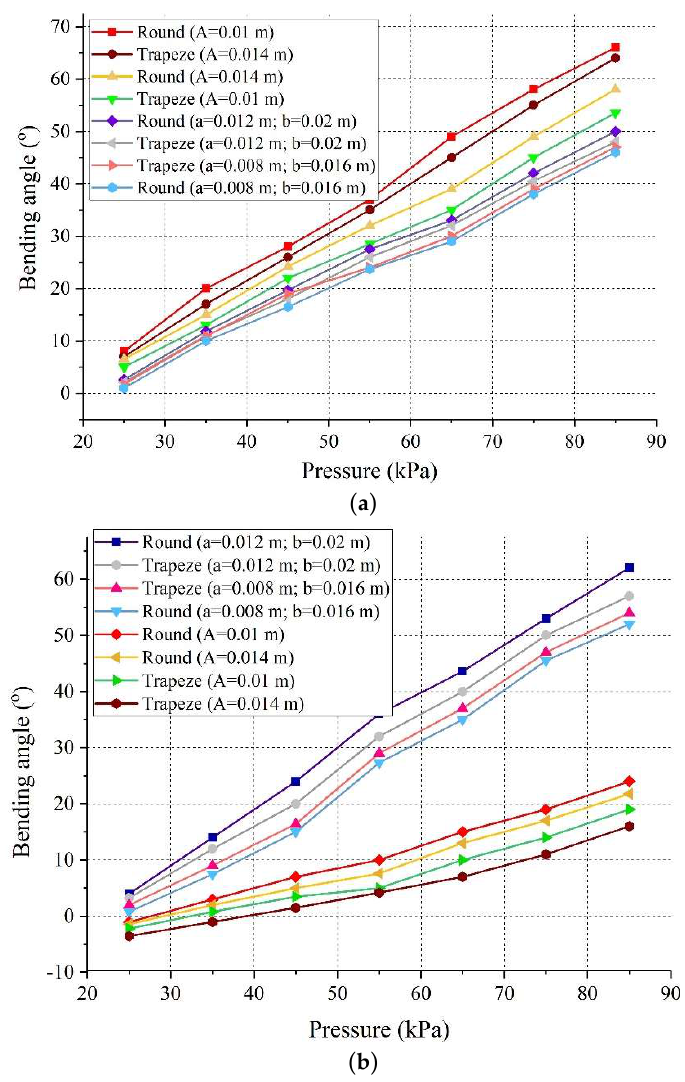
Figure 4. Comparison of finite element method (FEM) models: ( a ) Plot showing a comparison of the bending along the X -axis for each model, when the middle chamber was inflated. ( b ) Plot showing a comparison of the bending along the Y -axis of each model, when the side chamber was inflated.